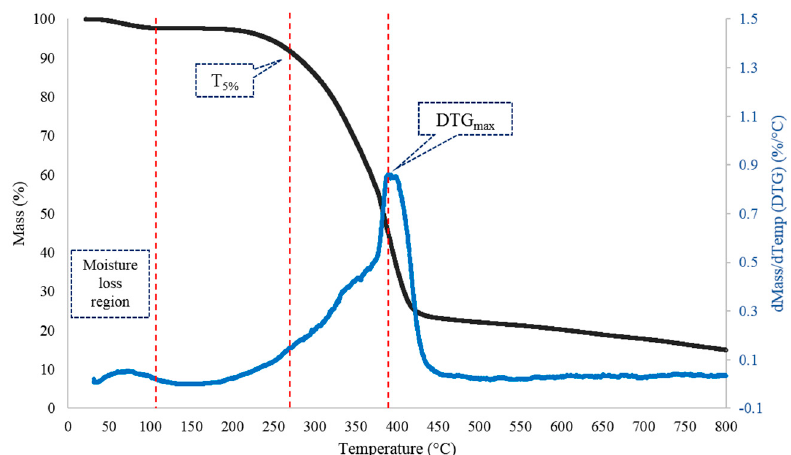
Figure 7. Mass loss curve (black curve) with its first derivative (blue curve) of a representative polymer sample. Moisture loss occurs until about 110 °C. After that, the polymer sample is thermally stable up to about 275 °C (where 5% mass loss occurs post-moisture loss) and the maximum mass loss is observed at the peak of the derivative, i.e., about 390 °C.